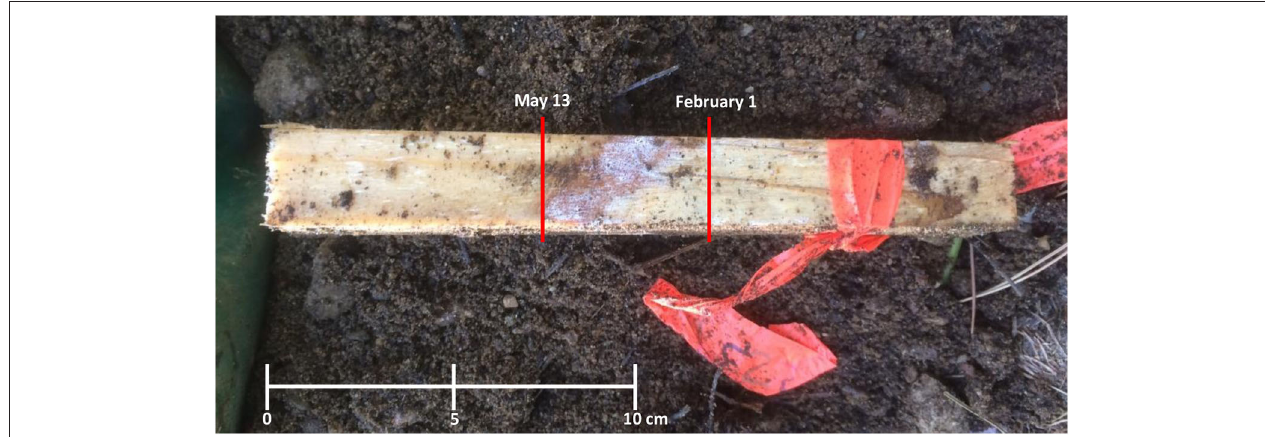
FIGURE 4 | Hypholoma fasciculare growth during winter and spring on pine block buried at 30cm depth. The white hyphae indicate growth of H. fasciculare . The area marked in red lines indicate the growth of H. fasciculare from February 1 to May 13,